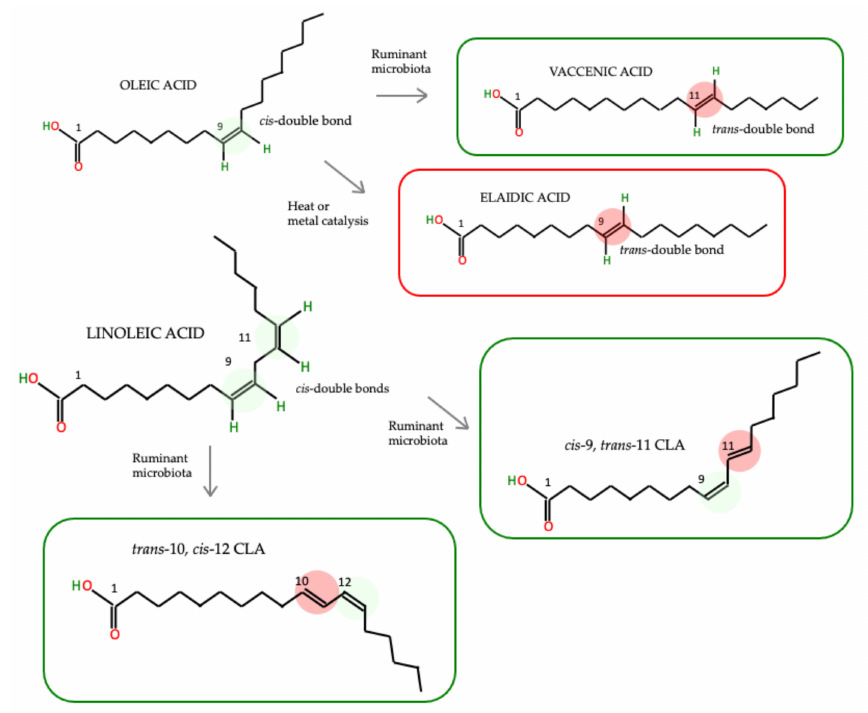
Figure 1. Chemical structure of the major TFA in the green box are nTFA; the red box is iTFA. Green highlighting: cis-double bonds; red highlighting: trans-double